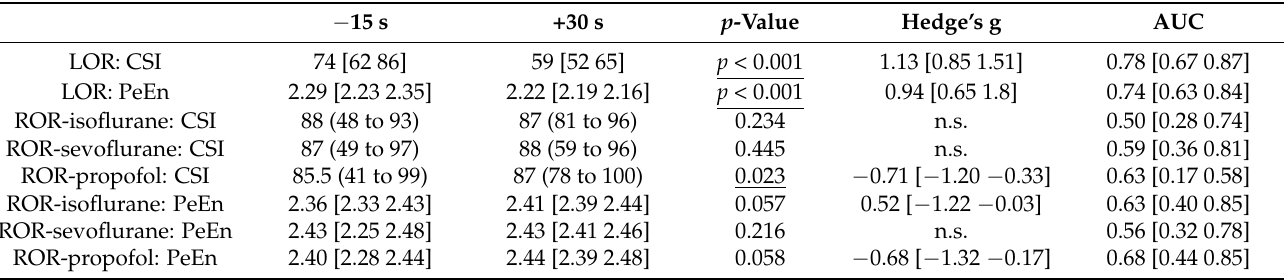
Table 2. Statistical parameters for the cerebral state index (CSI) and permutation entropy (PeEn) analysis at loss and return of responsiveness